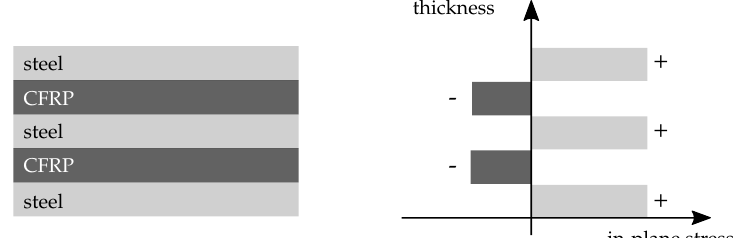
Figure 9. Residual stress state through the thickness in a generic FML after manufacturing at elevated temperature and cool down to room temperature.